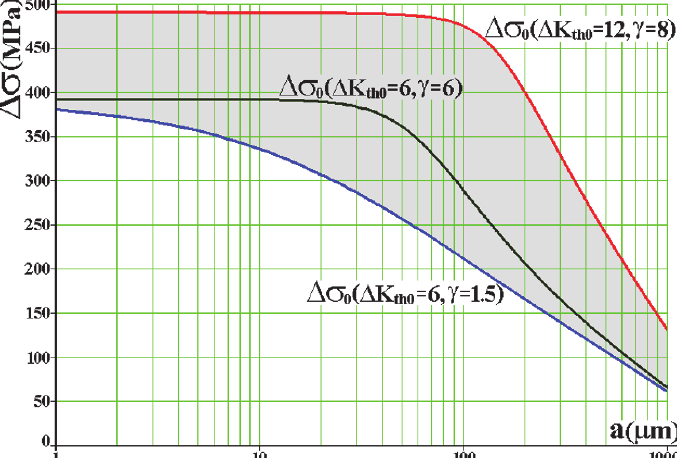
Figure 3: Influence of the typical ranges of FCG threshold 6 <  K th0 < 12MPa  m and of Bazant’s data-fitting exponent 1.5 <  < 8 on the largest stress ranges  0 tolerated by the studied